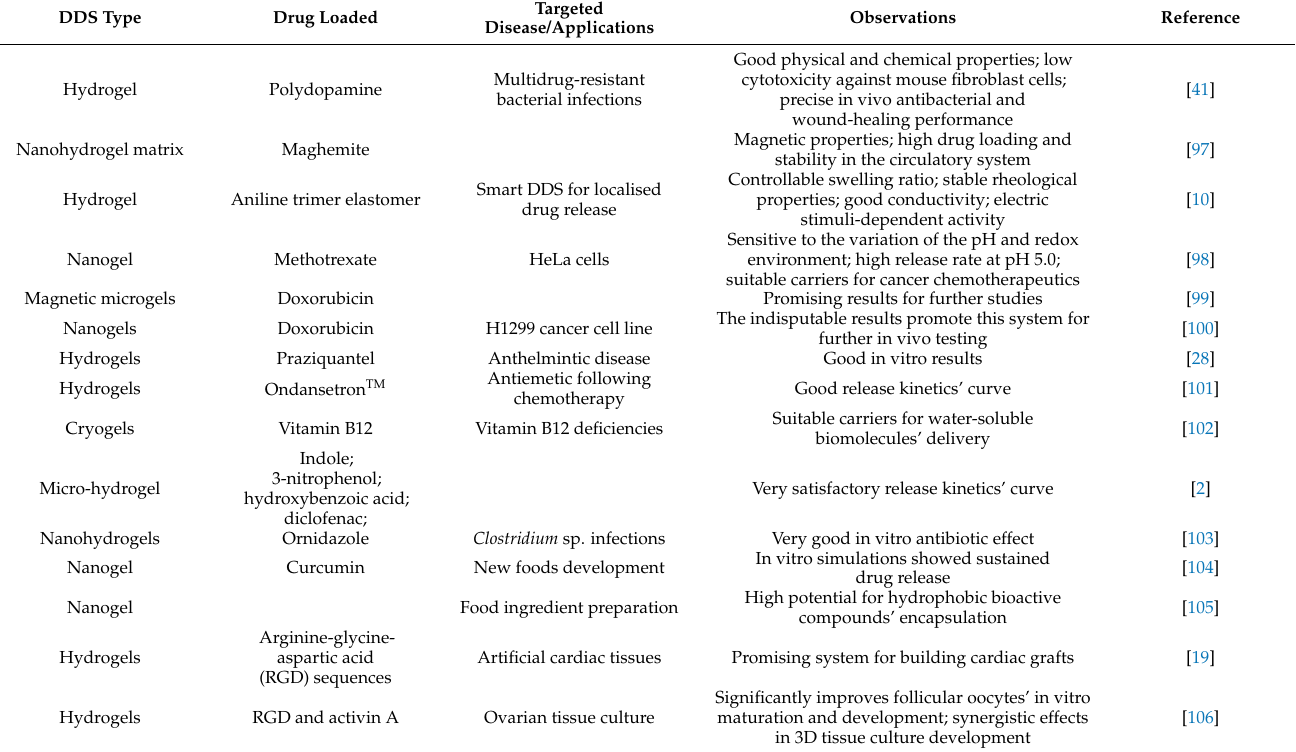
Table 2. Dextran applications in drug-delivery